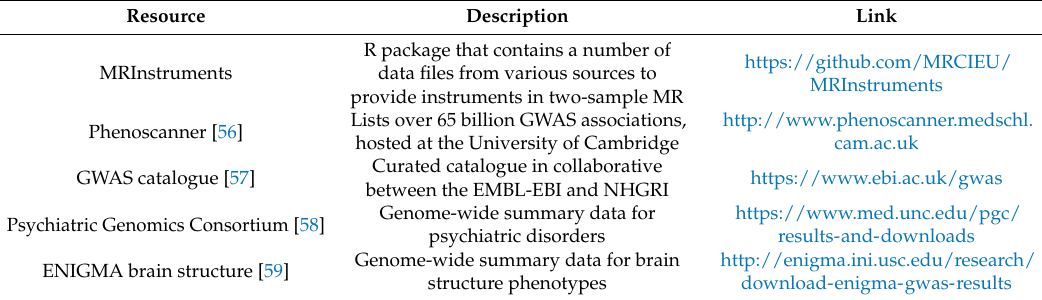
Table 4. Resources providing genome-wide association study (GWAS) summary statistics for (mental health) traits. EMBL-EBI: European Molecular Biology Laboratory - European Bioinformatics Institute; NHGRI: National Human Genome Research Institute; ENIGMA: Enhancing Neuro Imaging Genetics Through Meta